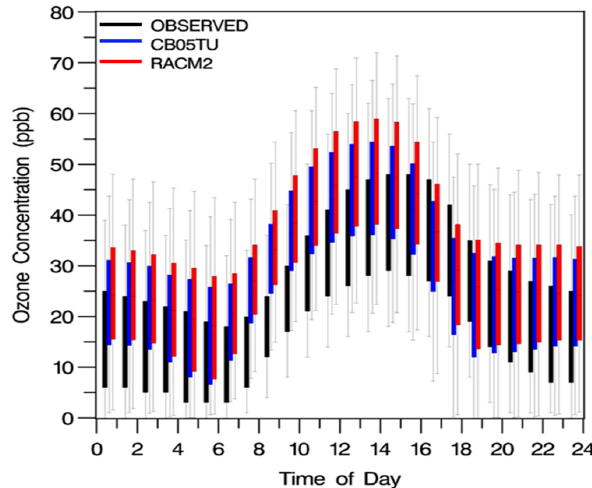
Fig. 6. A comparison of diurnal variation of predicted hourly sur- face O 3 obtained with CB05TU, RACM2 and observations from Air Quality System sites.